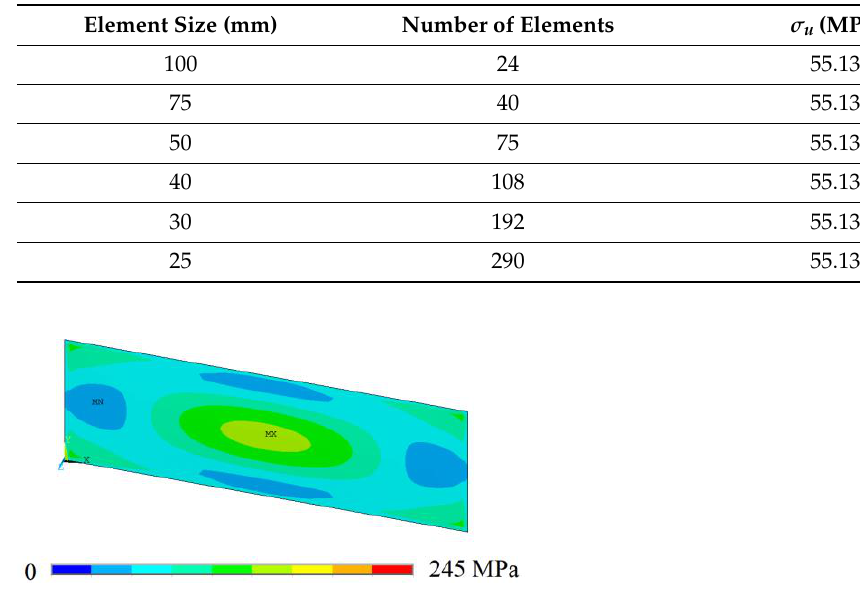
Figure 7. Simply supported square plate with centered circular hole. Shanmugam et al. [26] used an analytical approach to achieve the ultimate stress of 𝜎 𝑢 = 257.13 MPa, while the proposed computational model obtained 𝜎 𝑢 = 263.49 MPa. The difference between the results is 2.47%, verifying the developed numerical model. One can view the results generated by the present study in Table 4 and Figure 8.